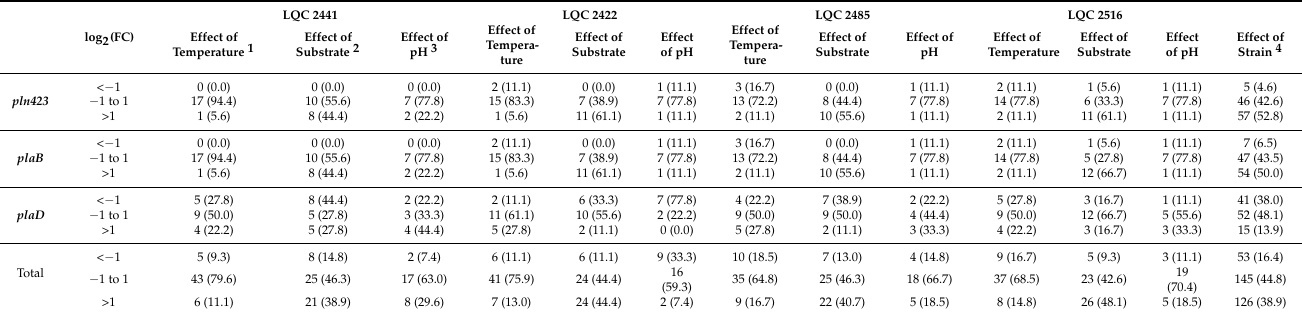
Table 3. Number of samples in which the relative transcription of the genes under study was below, above or within the threshold set under the effect of sourdough related parameters on Lp. plantarum strains LQC 2441, LQC 2422, LQC 2485 and LQC